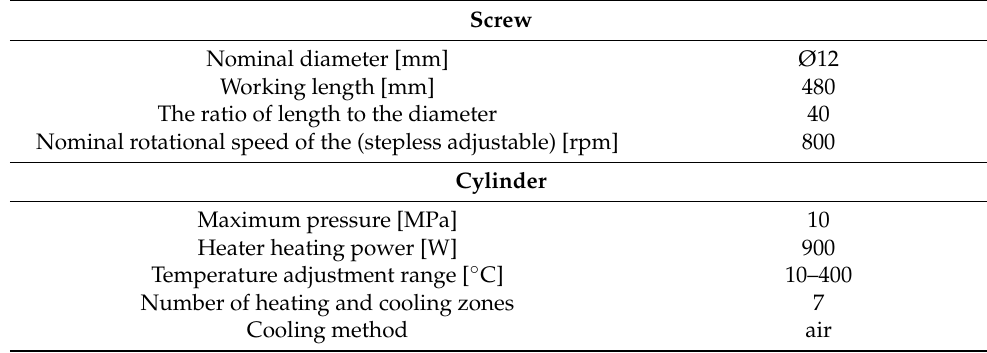
Figure 1. Extrusion line using ZAMAK REA-2P12A Explorer twin-screw extruder used to extrude the PHBV-hemp fiber and PHBV-flax-fiber biocomposites. Table 1. Technical data of the ZAMAK REA-2P12A Explorer extruder (based on